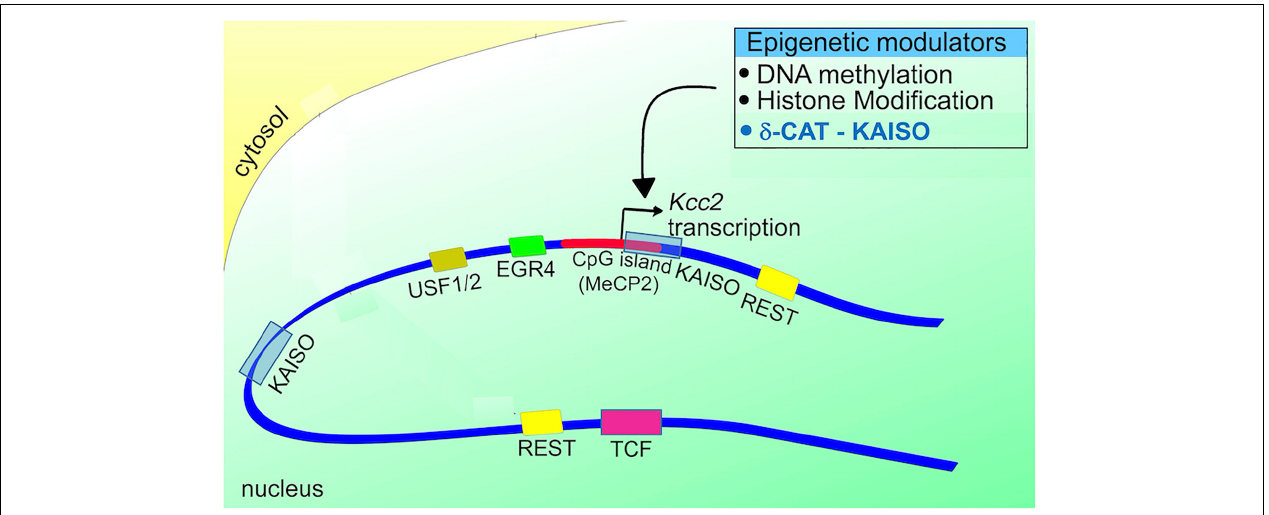
FIGURE 3 | Schematic representation of the Kcc2 promoter. Note the positioning of DNA binding sites for relevant transcriptional modulators in relation to the Kcc2 transcriptional start site. The connection to epigenetic regulation, suggested since the discovery of Kcc2 gene expression regulated by REST-RE-1 de-repression, is further enhanced by the impact of the CpG island surrounding the Kcc2 transcriptional start site, and the two Kaiso DNA binding sites “bracketing” the Kcc2 transcriptional start site. Since Kaiso-KAISO interactions, which by default are repressive, rely on DNA methylation, the delta-catenin—Kaiso interaction, as recently demonstrated in Yeo et al. (2021) is referenced as an epigenetic